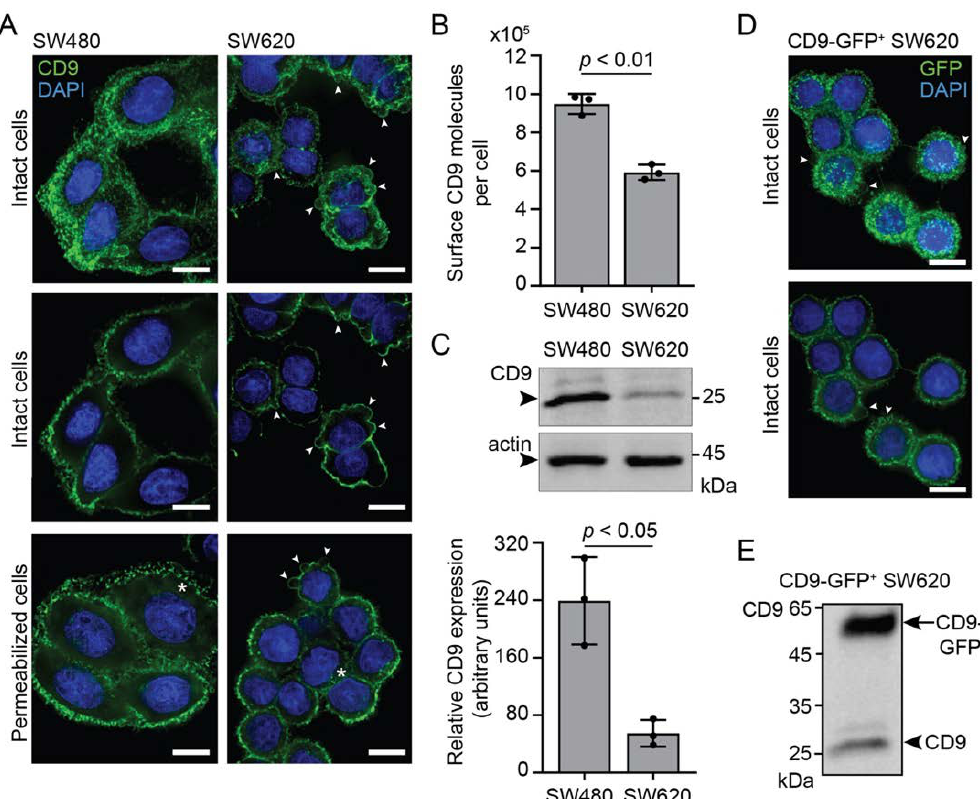
Figure 1. CD9 expression in SW480 and SW620 cells. ( A ) CD9 expression was investigated by indirect immunofluorescence labeling using anti-CD9 5H9 Abs on either intact or permeabilized SW480 and SW620 cells cultured on poly-D-lysine-coated dishes. Nuclei were stained with DAPI and samples were observed by CLSM. Composite images (top panels) or single x-y sections (middle and bottom panels) are shown. Arrowheads indicate membrane blebs, while asterisks mark cytoplasmic CD9 immunoreactivity. ( B ) The amount of surface CD9 antigens per cell detected with FITC-conjugated eBioSN4 Abs was estimated using a flow cytometer calibrated with fluorescent microparticles. ( C ) Total CD9 antigens were analyzed by immunoblotting (top panel) using 5H9 Abs and quantified (bottom panel). The samples were normalized to β -actin. Molecular mass markers (kDa) are indicated. Arrowhead indicates the protein of interest. ( D , E ) SW620 cells stably transfected with CD9-GFP were analyzed either by fluorescence microscopy without permeabilization ( D ) or immunoblotting ( E ). For the microscopy, nuclei were stained with DAPI and samples were observed by CLSM. A composite image (top panel) or a single x-y section (bottom panel) is displayed. Arrowheads indicate membrane blebs. For immunoblotting, the membrane was probed with 5H9 Abs. The arrow and arrowhead indicate the CD9-GFP fusion protein and the endogenous CD9, respectively. Means ± S.D. and individual values for each experiment are shown ( n = 3). p values are indicated. Scale bars, 10 µ